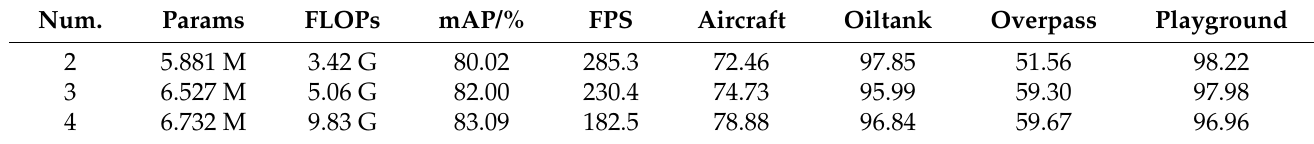
Table 3. Comparison of model size and accuracy under different number of prediction layers (Num.)